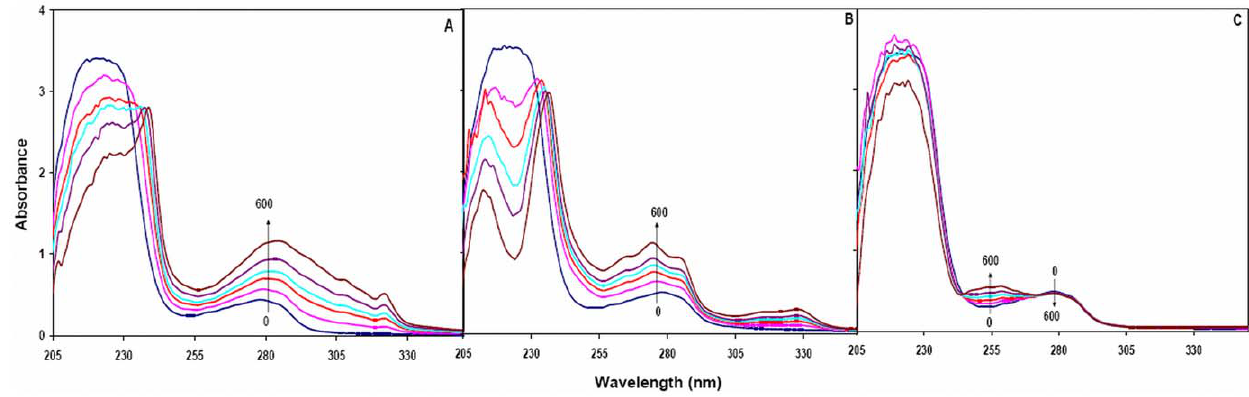
Figure 1. Absorption spectra of HSA gradually titrated with pollutants (A) 1N, (B) 2N, and (C) 8H at 37 6 C. HSA–pollutant spectra were subtracted from the spectra of equal amount of pollutants. HSA=12 m M and 1N=2N=8H=0 to 600 m M.